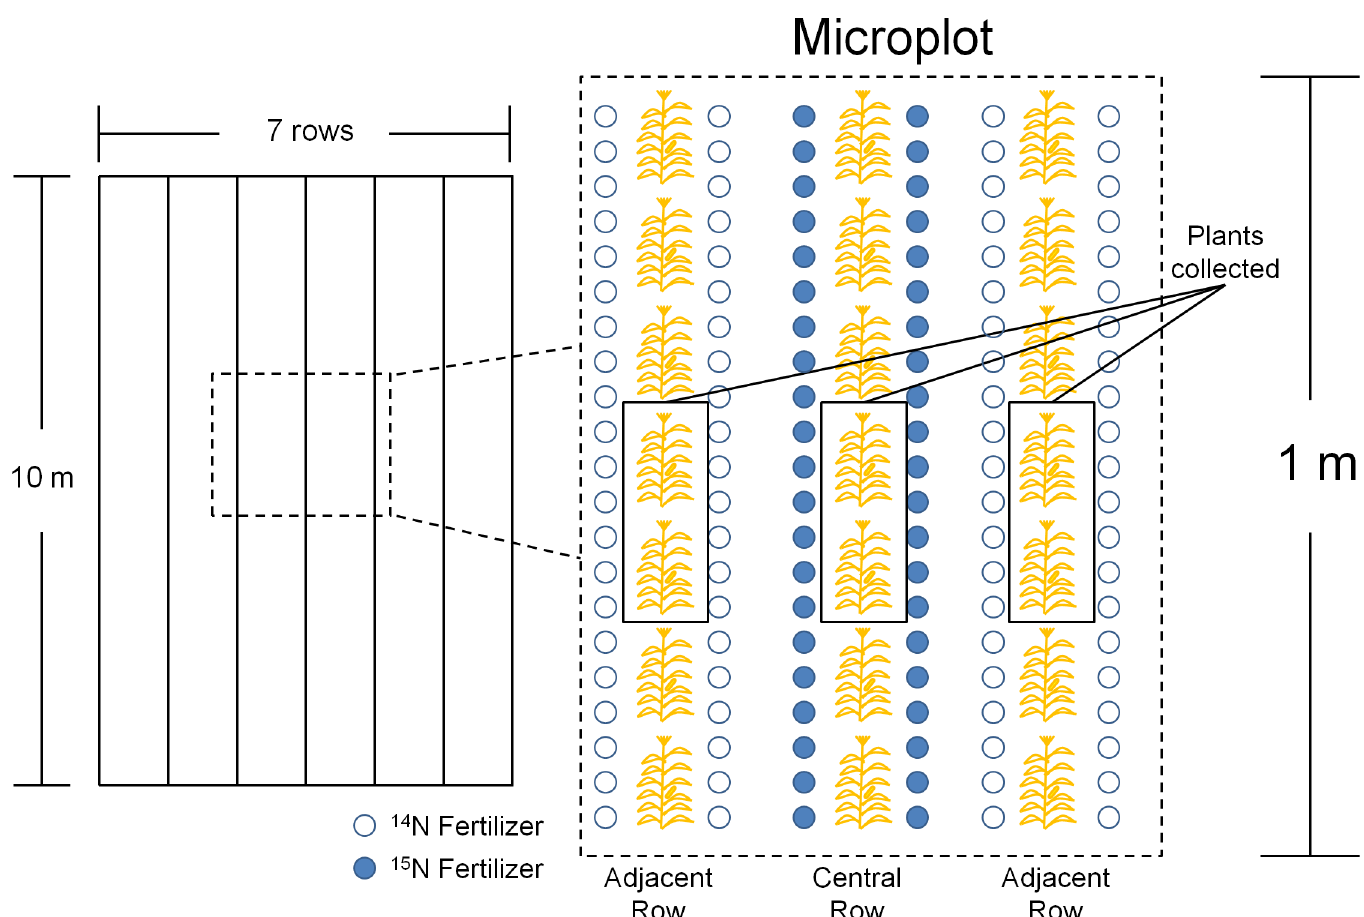
Fig 2. The isotopic labeled-N ( 15 N) fertilizer was applied only to the central microplot row installed in each plot. Plants were sampled from the center part of the adjacent and the central